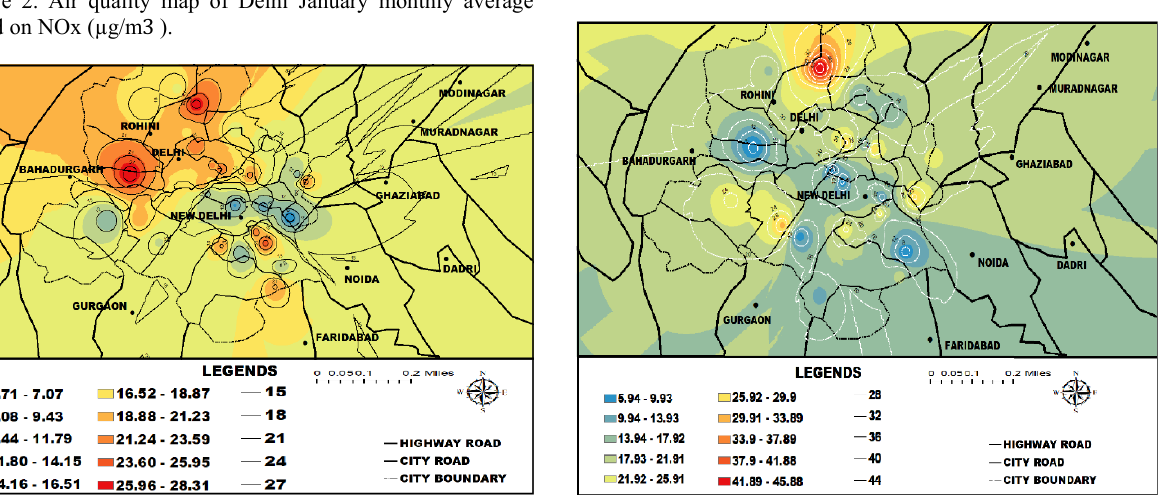
Figure 3. Air quality map of Delhi January monthly average based on SOx (µg/m 3 ).